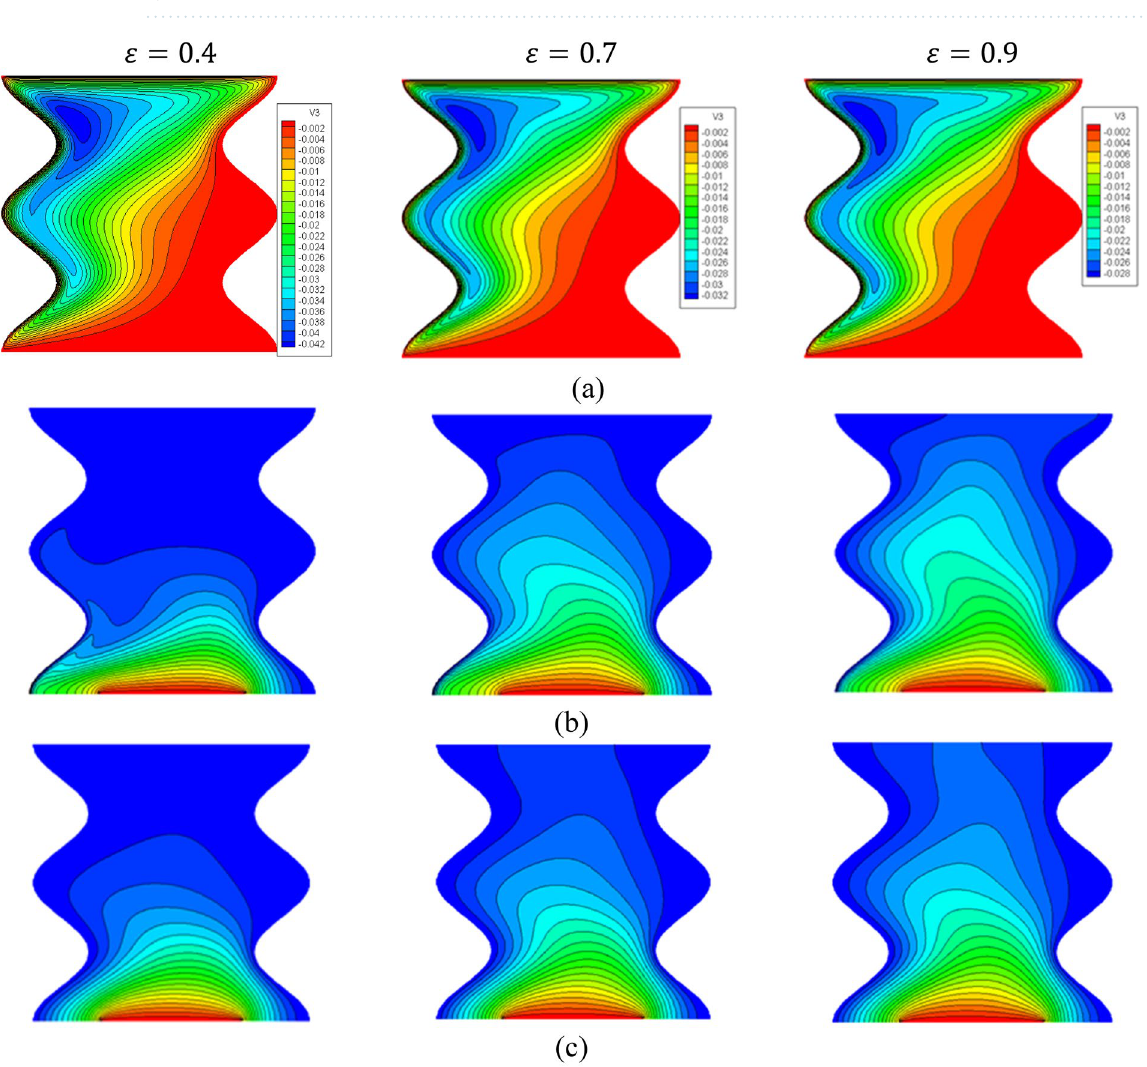
Figure 9. Variation of Nu ms along φ below the changes on the thermal radiation parameter R d for a hybrid nanofluid at φ Cu = φ TiO 2 = φ/ 2, B = 0.5, Q = 1, ε = 0.5, Da = 10 k r = 1, H ∗ = 10.